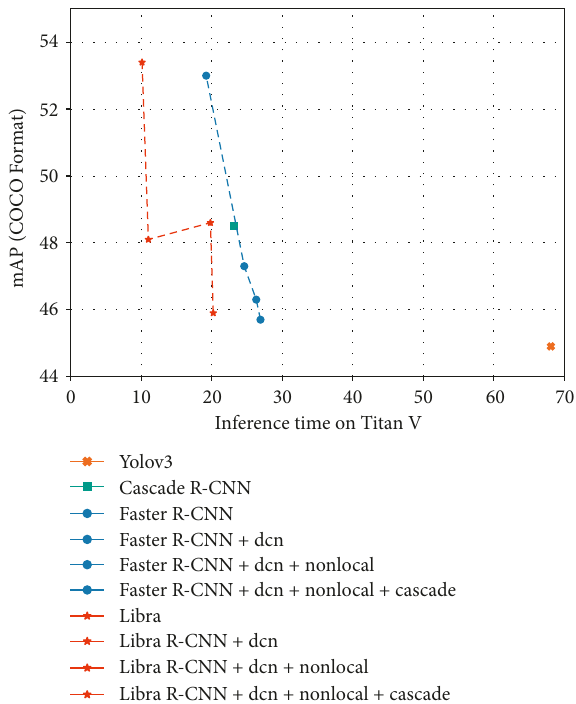
Figure 12: Visualization between inference time and mAPbest. It shows that the one-stage algorithm has its advantage in speed. The mAP of the two-stage algorithm rises as the above modules are added, but the computational complexity grows as